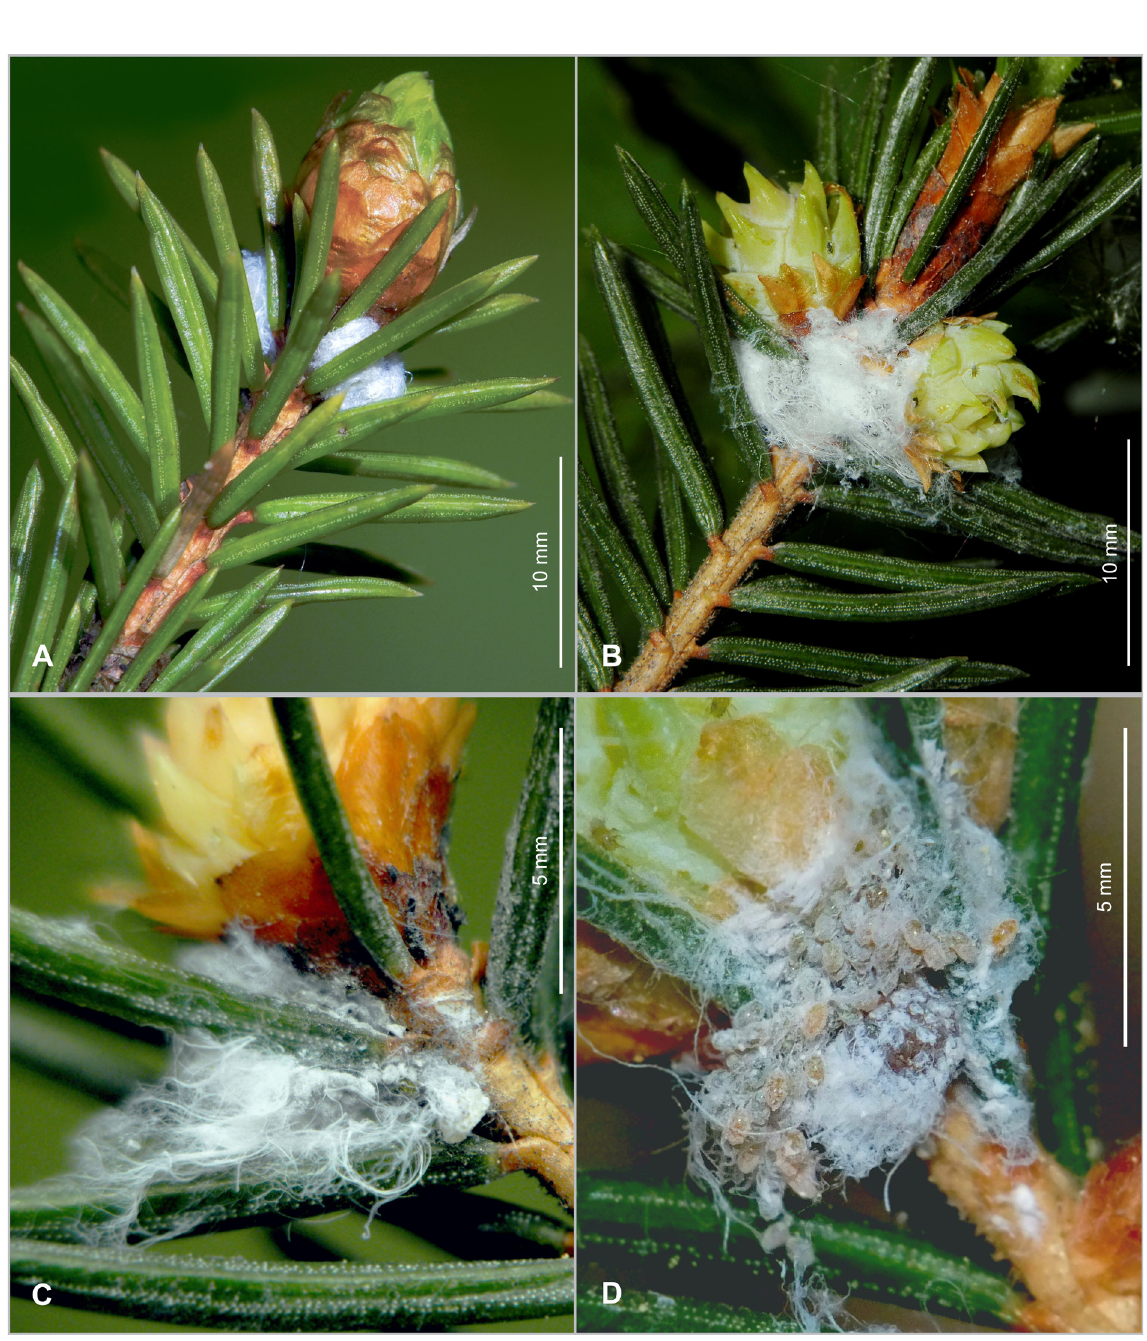
Fig. 13. A–C . Adelges (Adelges) tardus (Dreyfus, 1888). Wax-covered pseudofundatrices at bases of developing galls on Picea abies . D . As A–C, but with the wax wool brushed off to expose the pseudofundatrix and her